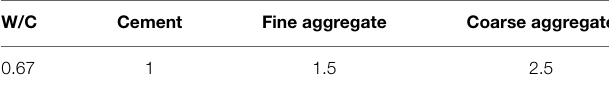
TABLE 1 | Concrete mix proportions by